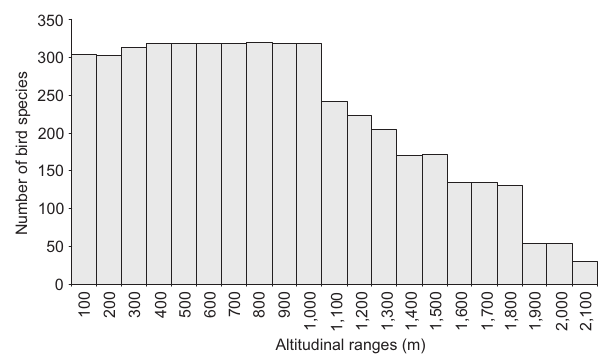
Figure 2. Species richness in each altitudinal range in the Serra dos Órgãos, southeastern